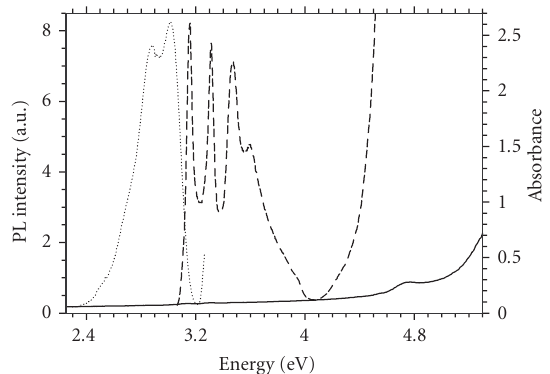
Figure 1: (a) Sketch of a silica particle with the expected gyroidal morphology, showing the arrangement of surfactant micelles. (b) Molecular structure of DPA.